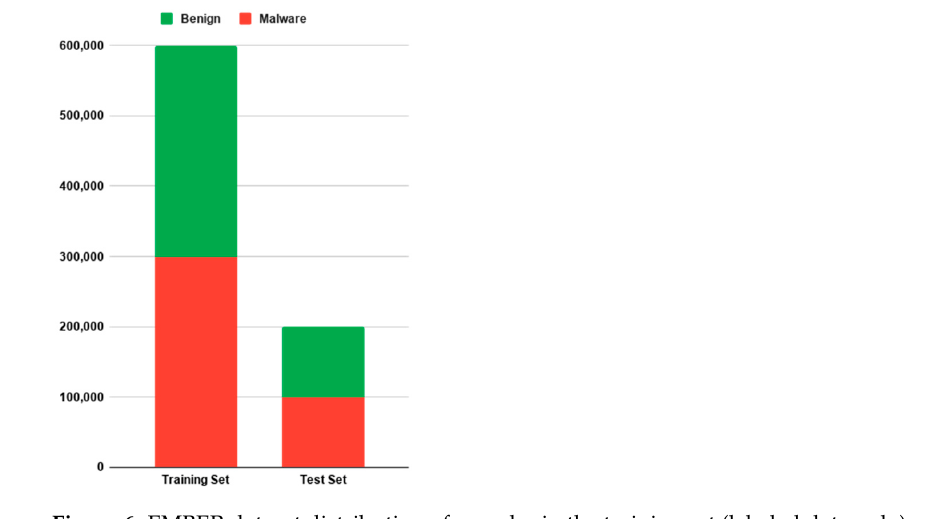
Figure 6. EMBER dataset distribution of samples in the training set (labeled data only).